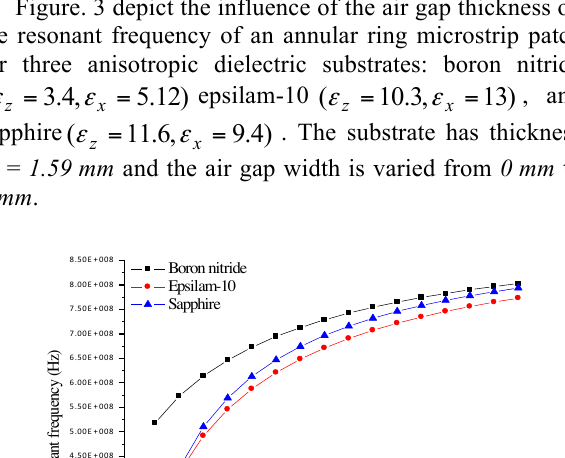
=35mm, r =2 r , ε =2.32 . 1 2 1 r2